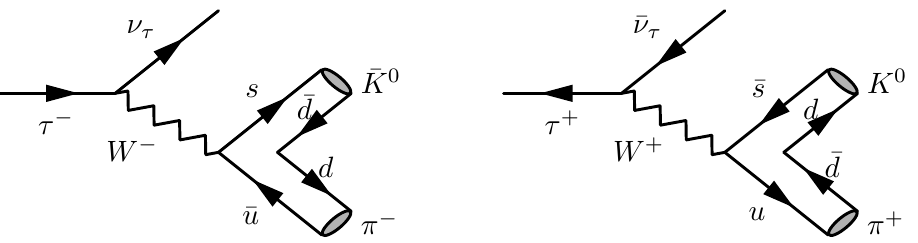
Figure 1 . Tree-level Feynman diagrams for the decay (cid:28) mode (cid:28) + ! K 0 (cid:25) + (cid:22) (cid:23) (cid:28) (right) within the